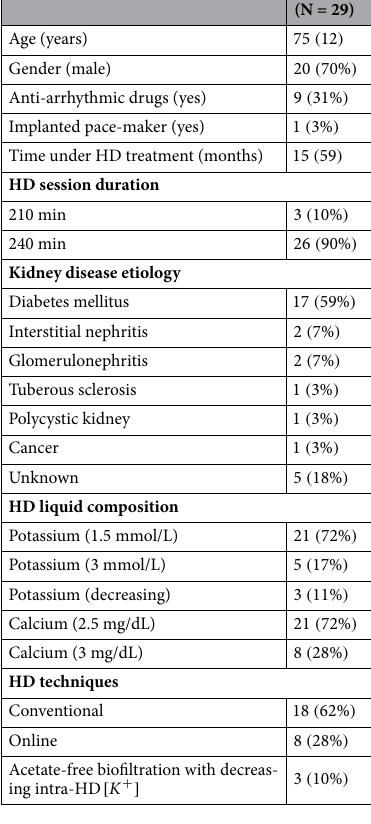
Table 1. Characteristics of the study population. Values are expressed as number ( % ) for categorical variables, and median (IQR) for continuous variables.